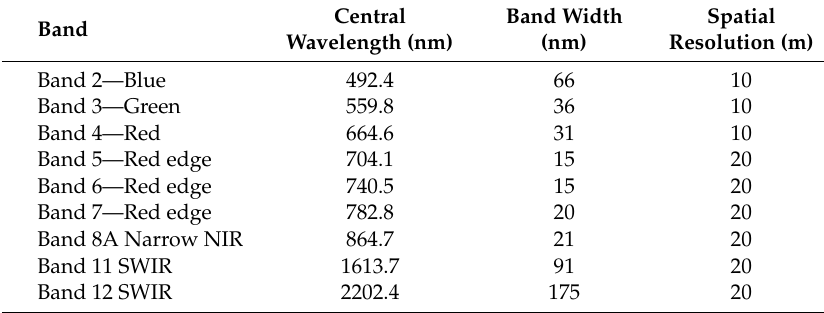
Table 2. Sentinel-2 spectral bands utilized in this study [36]. Bands with 10-m resolution were resampled to 20-m resolution during Sen2cor processing to maintain spatial resolution consistency across